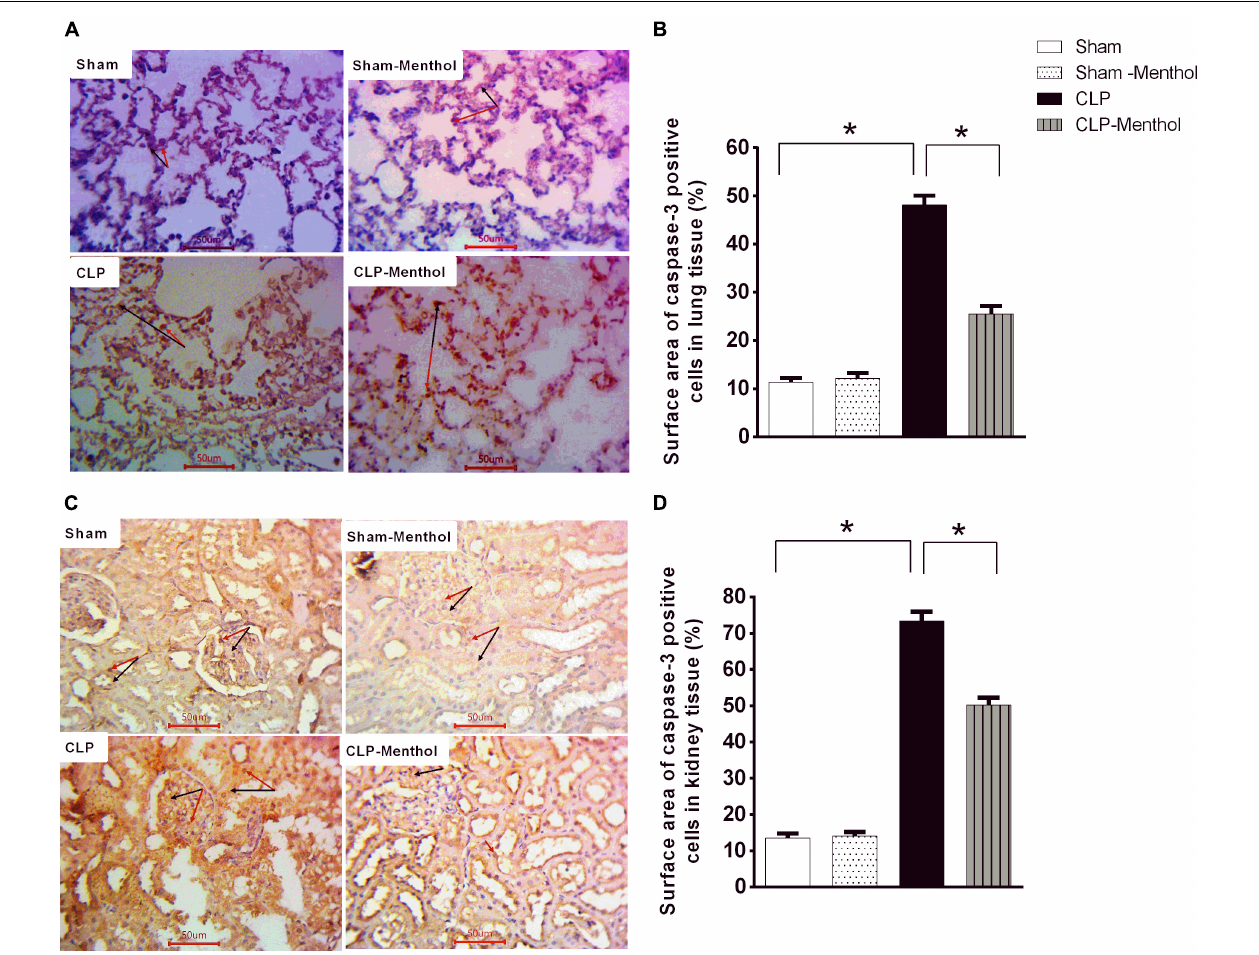
FIGURE 7 | Caspase-3 expression in the lung and kidney tissues of septic rats. Tissue levels of cleaved caspase-3 were determined semi-quantitatively by immunohistochemical staining of paraffin-embedded lung (A) and kidney (C) sections (see “Materials and Methods” section). Rabbit monoclonal anti-caspase-3 (cat. # ab32042, Abcam, Cambridge, United Kingdom) was used. Ten random fields per slide from each group ( n = 6) were selected and imaged (400 × ). The mean surface area fraction of caspase-3 immuno-positive cells was measured using ImageJ software. Representative photomicrographs (A) showing caspase-3 immunoreactivity in lung tissues. Summary data in the Bar charts (B) show semi-quantitative analysis of data in (A) from tissue sections of the sham, sham-Menthol, CLP, and CLP-Menthol groups. Data of caspase-3 immunoreactivity in kidney sections (C) from sham, sham-Menthol, CLP, and CLP-Menthol groups are semi-quantitatively analyzed in (D) . Data in the bar charts represent the mean ± SEM of 6 independent observations. Data were analyzed by one-way ANOVA followed by the Tukey-Kramer post- test for multiple comparisons. *Significantly different at p < 0.05 compared to the CLP